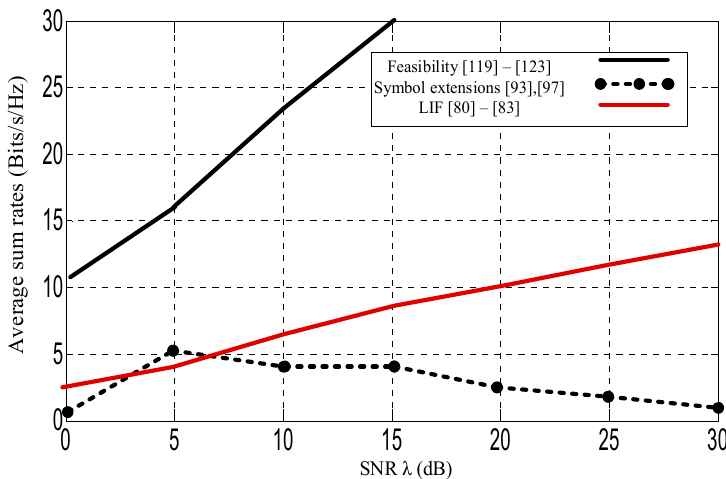
Figure 8. Average sum rates against typical SNR values for the second paradigm with SWF for the multiple SU MIMO link [80–83,93,97,119–123].